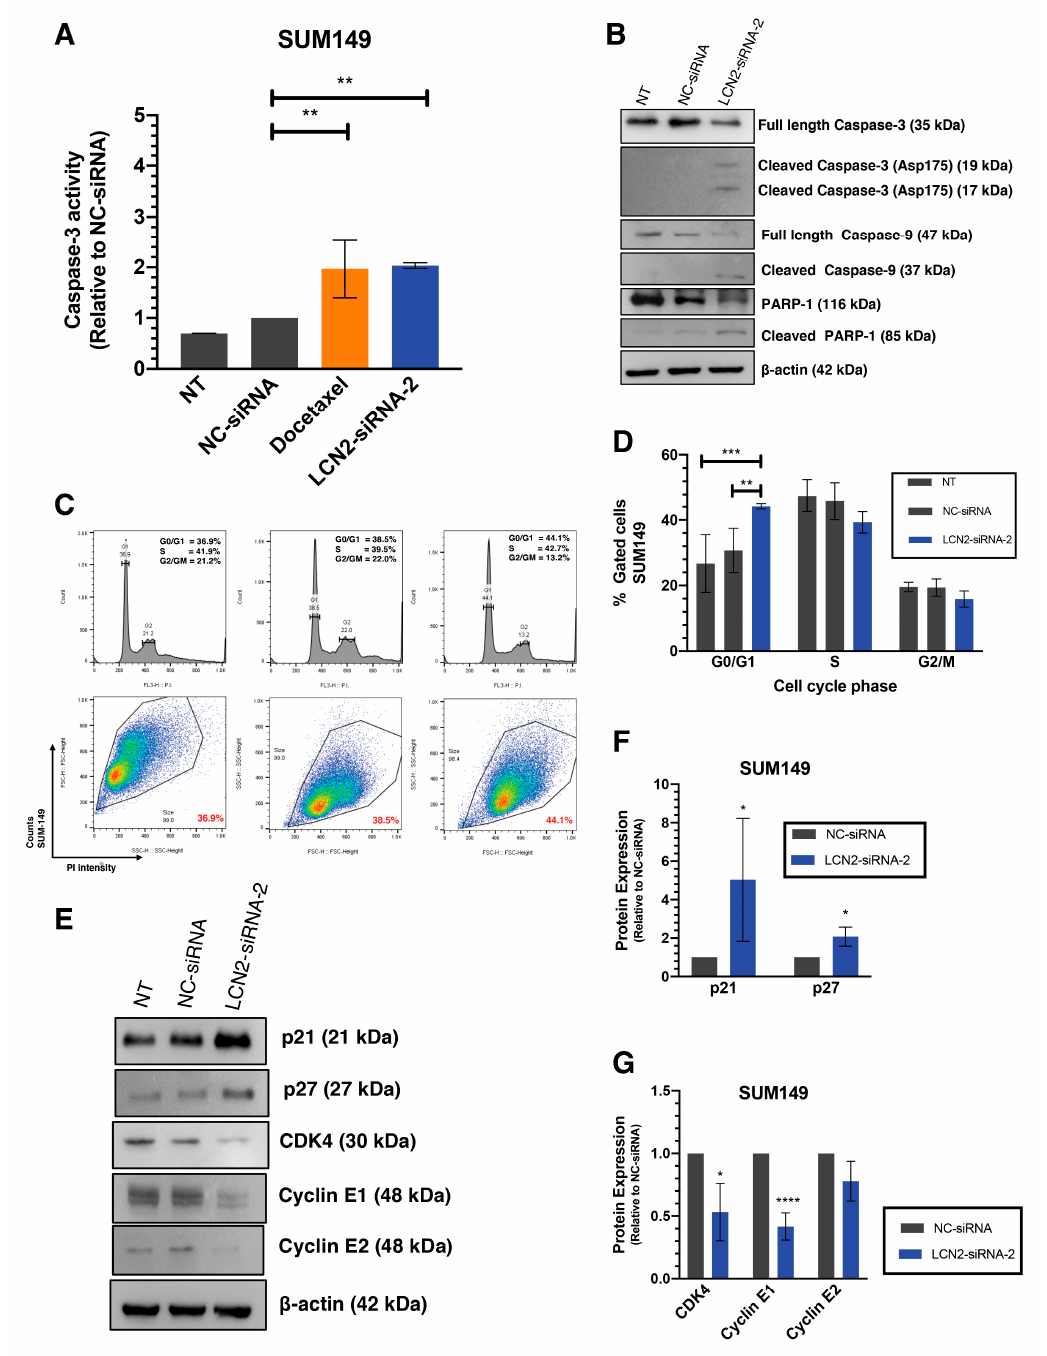
Figure 3. LCN2-siRNA-based silencing induces apoptosis and cell cycle arrest in IBC cells. SUM149 cells were transfected with 100 mM of negative control (NC-siRNA) or LCN2 siRNA (siRNA-2). ( A ) Caspase-3 fluorometric activity assay in SUM149 cells 72 h after LCN2-siRNA-2 and NC-siRNA transfection. Docetaxel (0.5 nM final concentration) was used as a positive control. ( B ) Western blot analysis of apoptotic-related proteins. ( C ) Histogram showing cell cycle arrest at G0/G1 to S phase transition after LCN2-siRNA-2 transfection in SUM149 cells compared with NC-siRNA. ( D ) Quantification of the flow cytometry data showed an increase in SUM149-LCN2-siRNA-2 transfected cells at G0/G1 to S phase transition. ( E ) Western blot analysis of cell cycle-related proteins 72 h after siRNAs transfection. ( F , G ) Densitometric analysis of the band intensities showed in E. Results are shown as Mean ± SEM of triplicate experiments (* p < 0.05, ** p < 0.01, *** p < 0.001, **** p <